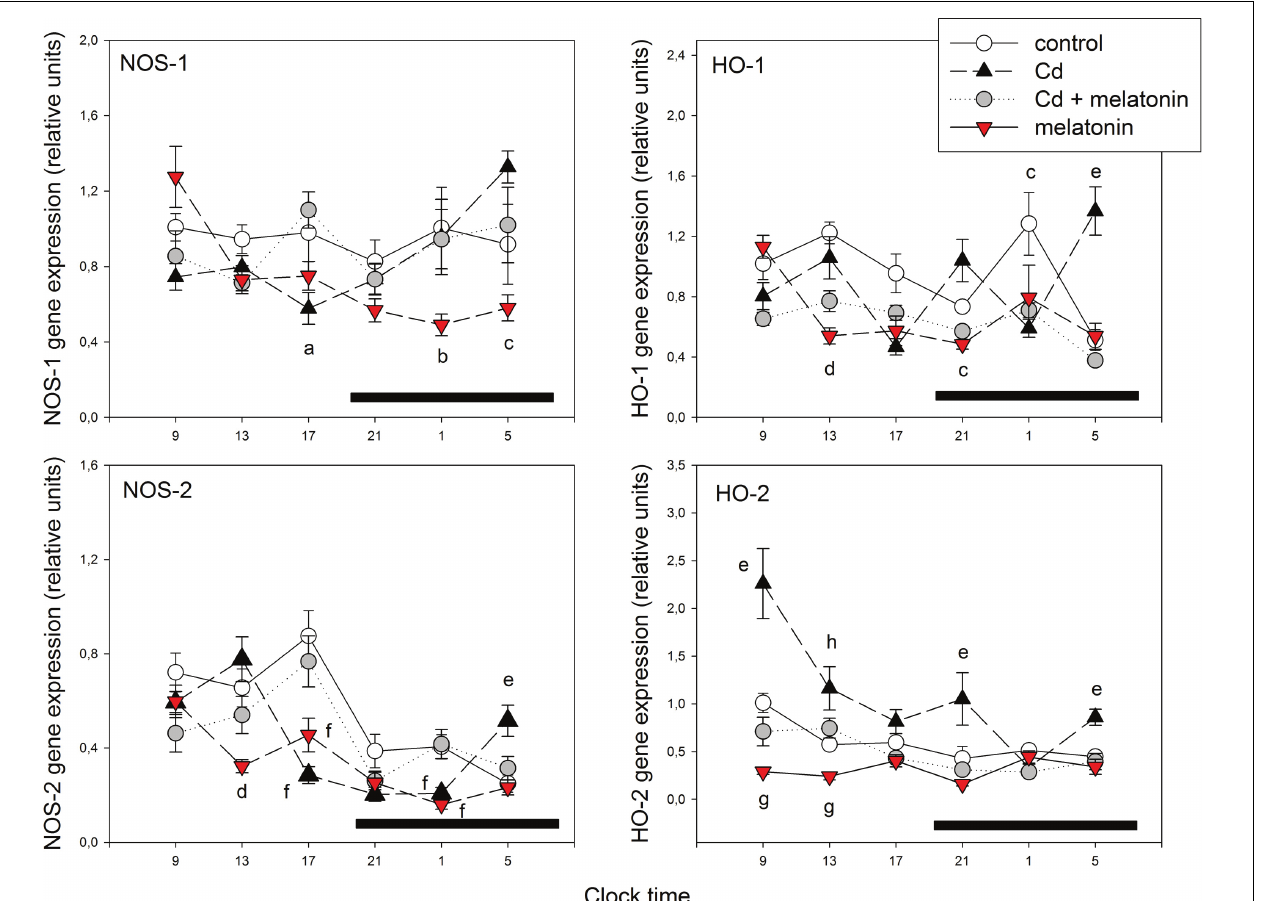
FIGURE 3 | Effect of melatonin on Cd-induced changes in 24-h pattern of expression of mRNA for NOS-1, HO-1, NOS-2, and NOS-2 in rat MBH. For experimental details see legend to Figure 1 . mRNA levels encoding the enzymes were measured as described in the text. Shown are the mean ± SEM of mRNA determination as measured by triplicate real-time PCR analyses of RNA samples. Letters denote significant differences in a one-way ANOVA followed by a Bonferroni’s multiple comparison test performed at every time interval, as follows: a p < 0.05 vs. Cd + melatonin group; b p < 0.05 vs. the remaining groups; c p < 0.02 vs. Cd; d p < 0.02 vs. control and Cd groups; e p < 0.01 vs. the remaining groups; f p < 0.02 vs. control